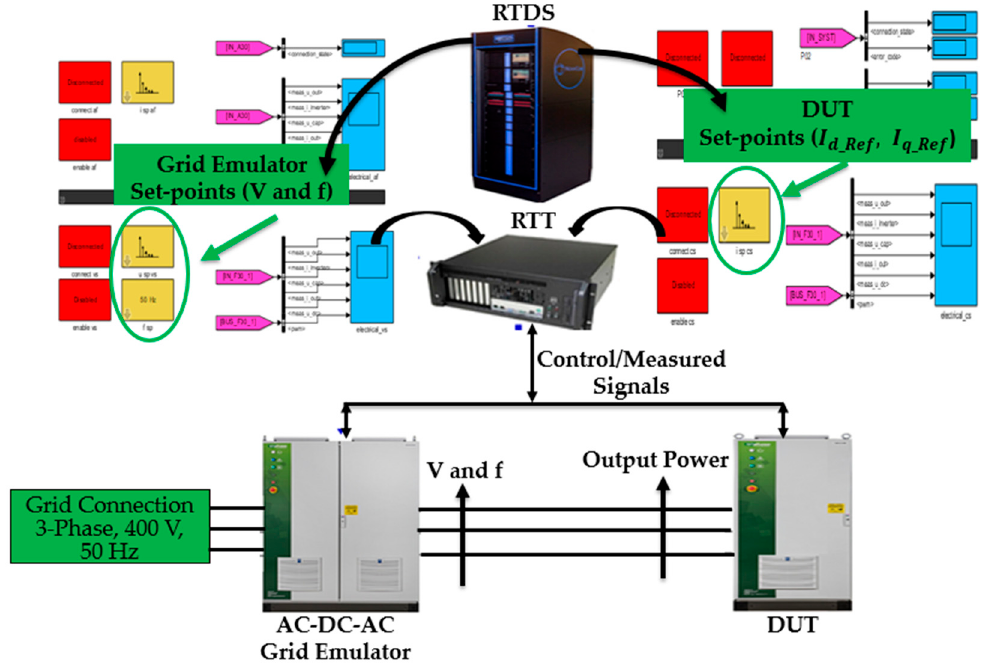
Figure 3. Working illustration of the PHIL methodology.